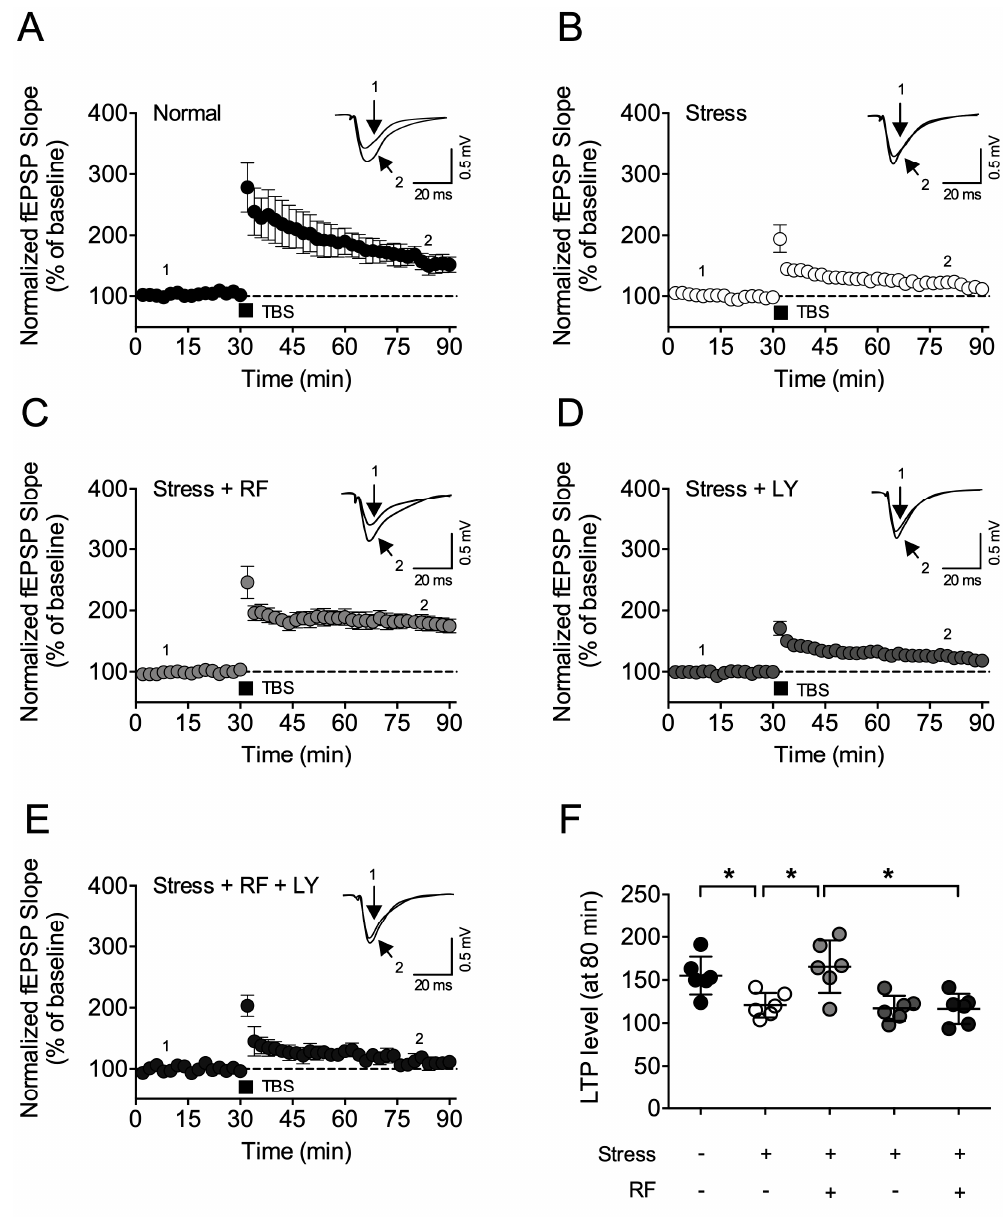
Figure 9. Effect of LY294002 on the effect of rubrofusarin on synaptic deficit: Long-term potentiation in the Schaffer-collateral pathway was induced by theta burst stimulation (TBS, 5 trains of 4 pulses at 100 Hz) after 30 min stable baseline. ( A ) Normalized fEPSP slop of normal group for 90 min. ( B ) Normalized fEPSP slop of CRS (stress) group for 90 min. ( C ) Normalized fEPSP slop of stress + RF (30 mg/kg) group for 90 min. ( D ) Normalized fEPSP slop of stress + LY294002 (LY, 1 nmol, 3 µl, i.c.v.) group for 90 min. ( E ) Normalized fEPSP slop of stress + RF (30 mg/kg) + LY (1 nmol, 3 µl, i.c.v.) group for 90 min. Data represented as mean ± SD. ( F ) Normalized fEPSP slop of each group during last 10 min. Data represented as mean ± SD with raw data. * p < 0.05.